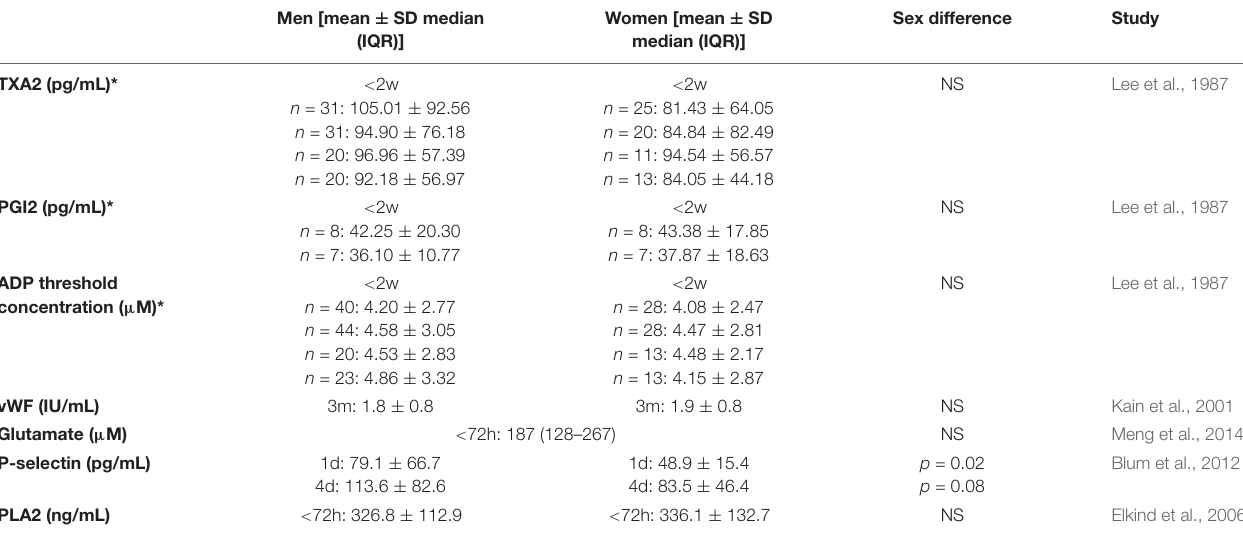
TABLE 1 | Primary hemostatic